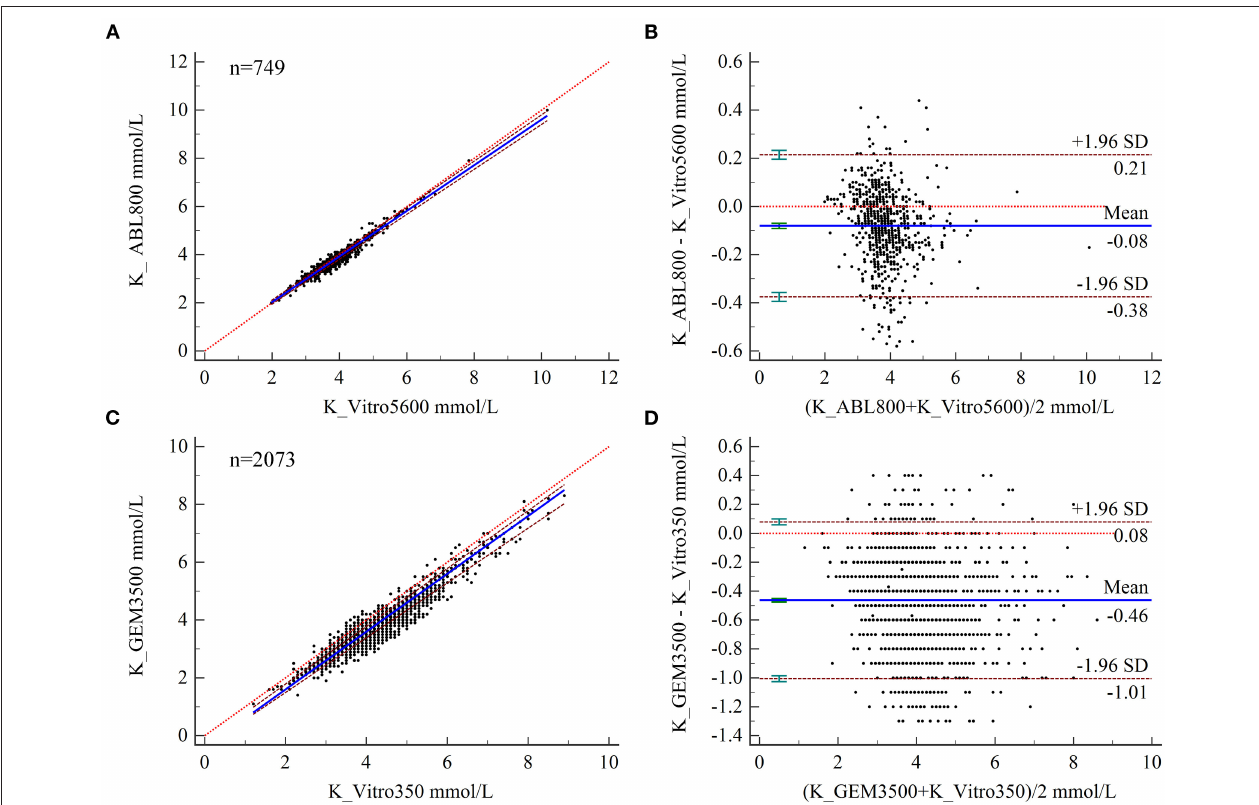
FIGURE 1 | (A,B) Scatter diagrams showing the results of Passing–Bablok regression analysis of the comparisons of potassium (K) levels in arterial and venous blood samples between the ABL800 FLEX and VITROS5600 systems (A) and between the GEM3500 and VITROS350 systems (B) . The graph shows the observations together with the regression line (solid blue line), the confidence interval for the regression line (dashed lines), and the identity line ( x = y , dotted line). (C, B) Results of Bland–Altman analysis of the comparisons of K levels in blood and venous serum samples between the ABL800 FLEX and VITROS5600 systems (C) , and the GEM3500 and VITROS350 systems (D) , showing the 95% limits of agreement (LoA). The scatter diagram shows the differences plotted against the averages of the two measurements. Horizontal lines are drawn at the mean difference and the